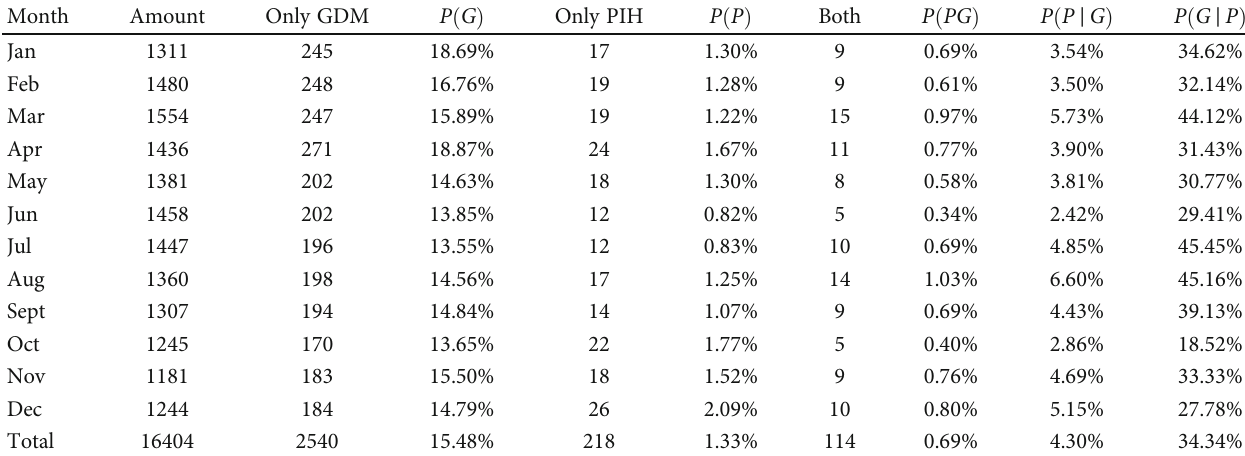
Table 1: Statistical results distributed by